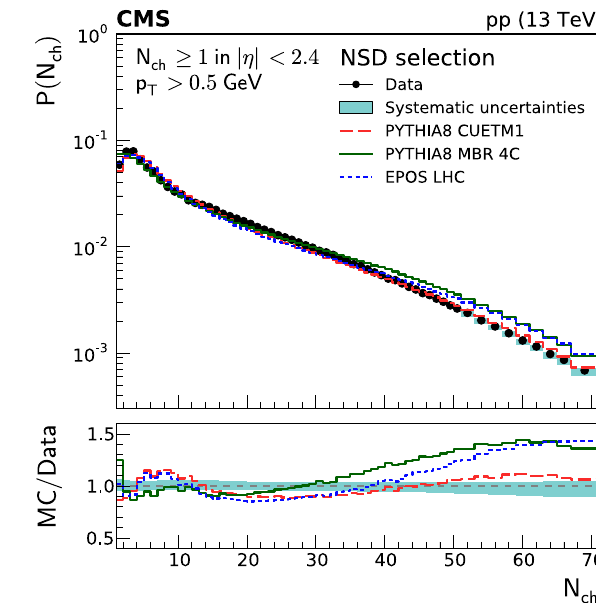
Fig. 3 Charged particle multiplicitydistributions of the inelastic (left), and NSD-enhanced (right) event samples. The measurements are com- pared to the predictions of the pythia 8 cuetm1 (long dashes), pythia 8 mbr4c (continuous line), and epos LHC (short dashes) event genera-